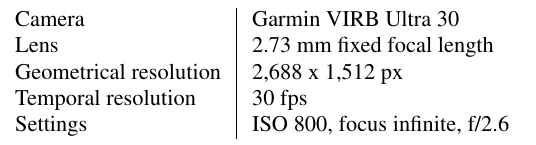
Table 2: Technical specifications and video recording parameters of the action cameras used in the test car to record videos (Pem- ble, 2017).